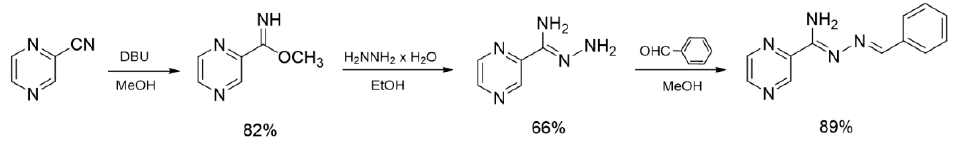
Figure 9. Synthesis route of the